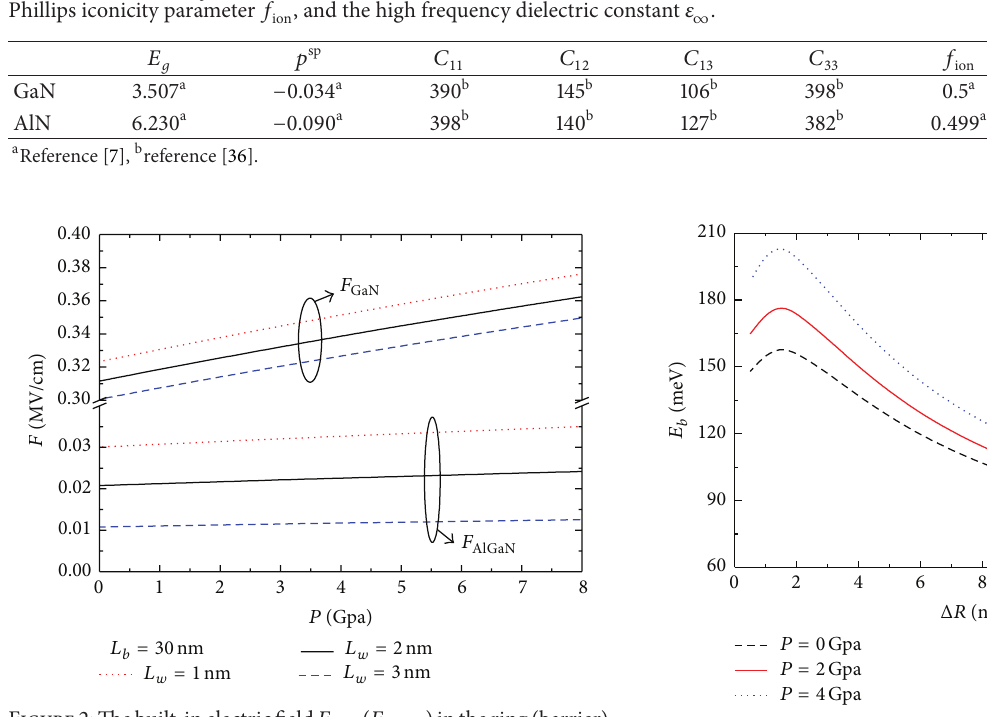
Figure2:Thebuilt-inelectricfield 𝐹 ( 𝐹 )inthering(barrier) GaN AlGaN Figure 3: The ground-state donor binding energy in cylindrical layer along the QR growth direction as a function of the hydrostatic wurtzite GaN/Al 𝑥 Ga 1−𝑥 N strained QR as a function of the radial pressure 𝑃 in cylindrical wurtzite GaN/Al 𝑥 Ga 1−𝑥 N strained QR with thickness (Δ𝑅) for 𝑅 1 = 4 nm, 𝐿 𝑤 = 4 nm, 𝐿 𝑏 = 20 nm, and several different QR heights. values of the hydrostatic